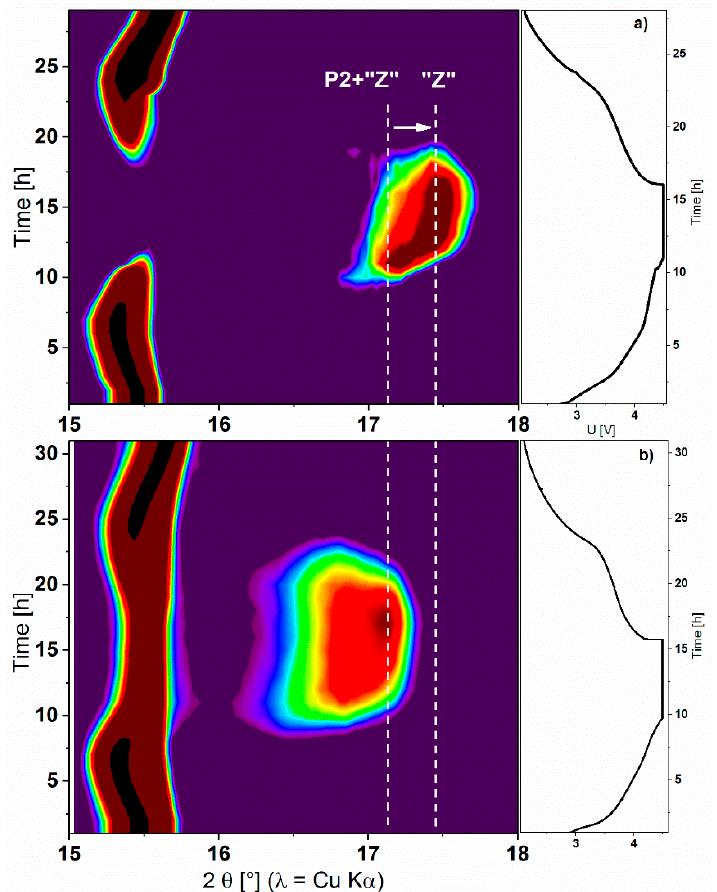
Figure 6. Contour plot representation of an Operando XRD experiment of ( a ) the pristine NaMFC and ( b ) the NaMFC_stirred materials cycled vs. Na at a rate of C/10 and their corresponding galvanostatic curves.